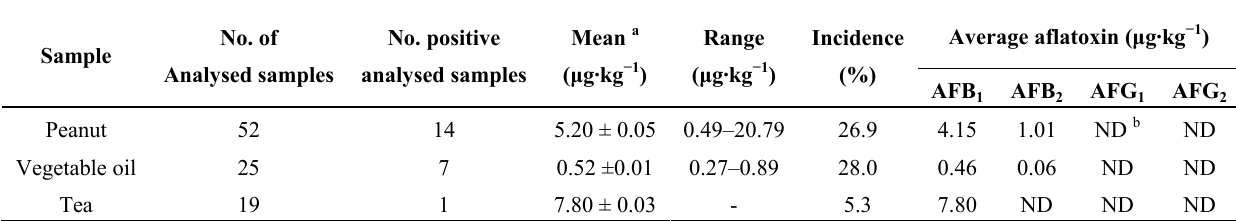
Table 4. Results for the determination of AFT in